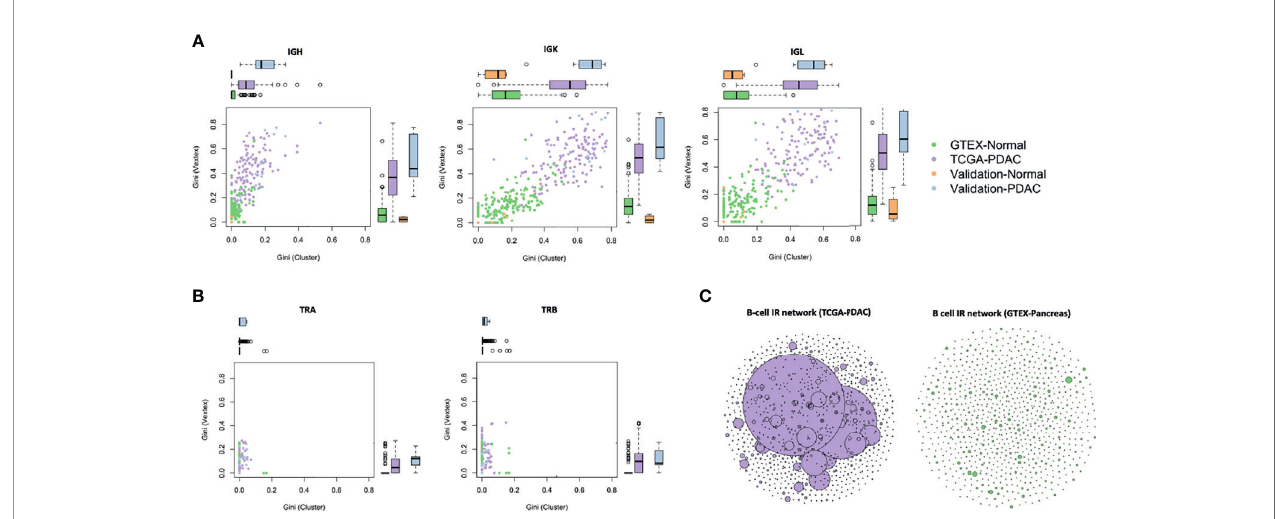
FIGURE 3 | Network analysis. Vertex Gini Index plotted against Cluster Gini Index for IGH, IGK, and IGL (A) , and TRA and TRB (B) . The scatter plot represents each sample. Boxplots show the Gini(V) and Gini(C) differences. p -values (TCGA vs . GTEx) − IGH: p (Gini(V ) < 2.2 × 10 − 16 , p ( Gini(C) TCGA vs . GTEx )< 2.2 × 10 − 16 ; IGK: p (Gini(V ) < 2.2 × 10 − 16 , p ( Gini(C) TCGA vs . GTEx )< 2.2 × 10 − 16 ; IGL: p (Gini(V ) < 2.2 × 10 − 16 , p ( Gini(C) TCGA vs . GTEx )< 2.2 × 10 − 16 . B-cell repertoire networks (C) from two samples representing one PDAC from TCGA (purple) and one normal pancreas from GTEx (green). Each vertex represents a unique BCR being the vertex size de fi ned by the number of identical BCRs considering the nucleotide sequences. An edge exists between vertices when they belong to the same clone as de fi ned before, so clusters are groups of interconnected vertices forming a clone.